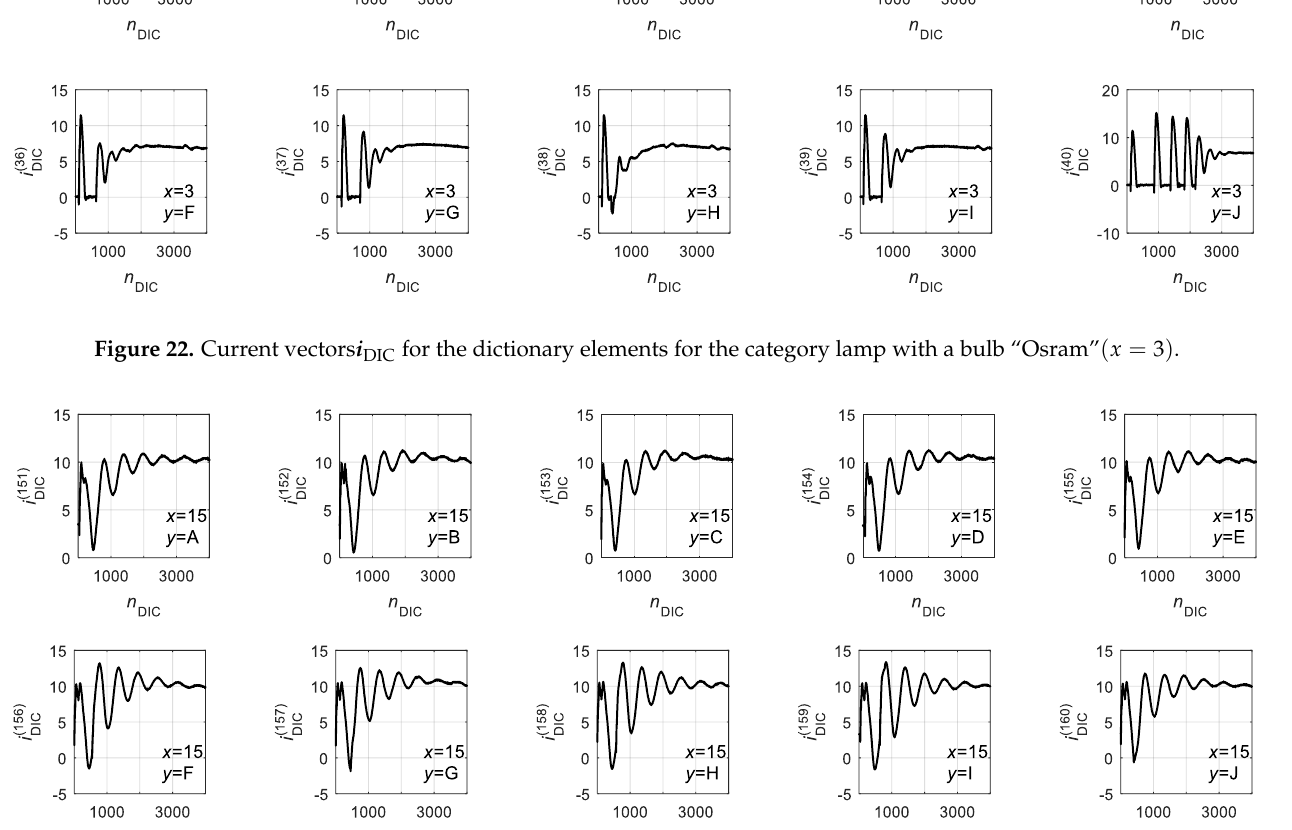
i for the dictionary elements for the category lamp with a bulb “Osram” = ( 3 ) x . Figure 22. Current vectors D I C